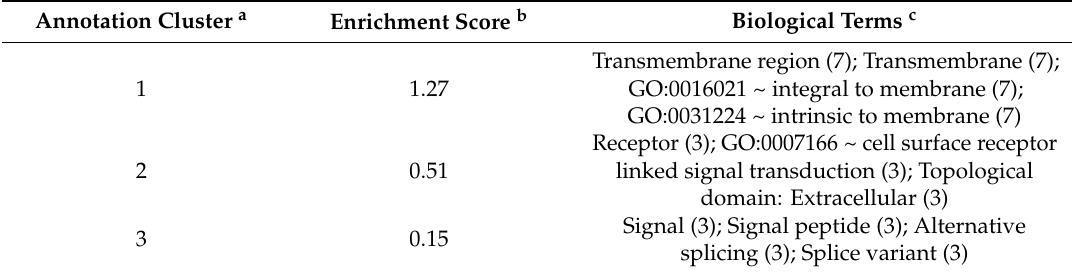
Table 3. Functional annotation clusters of biological terms representing upregulated genes in NR non-IUGR compared to NR IUGR